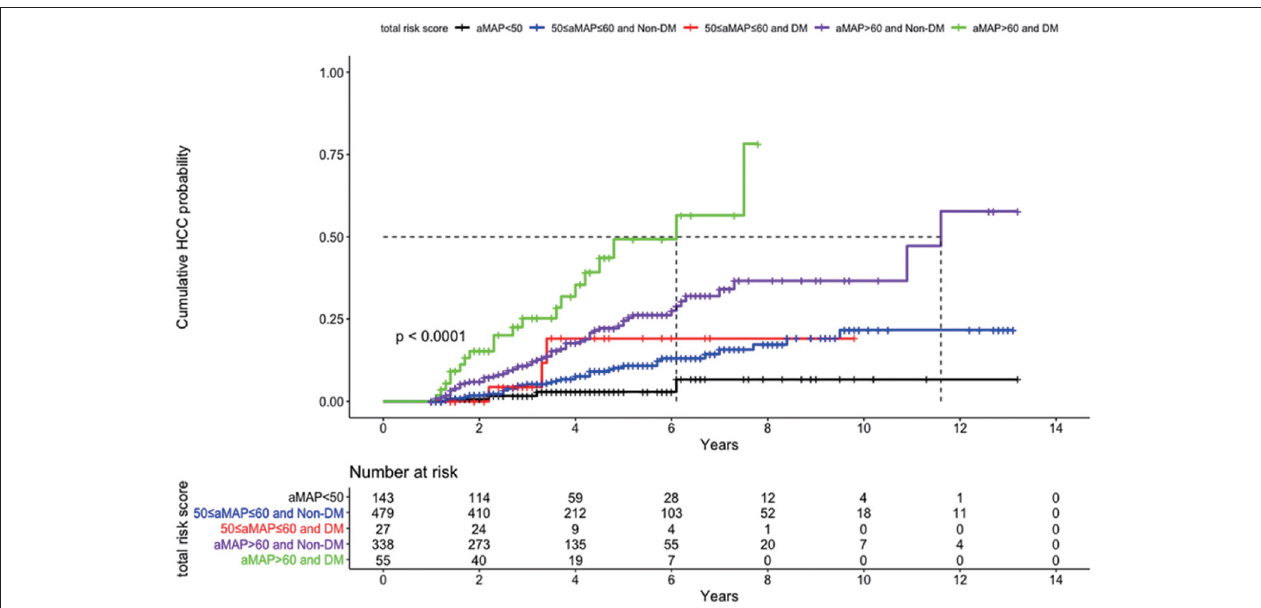
FIGURE 3 | Cumulative probability of development of HCC according to risk stratification by combination of aMAP and DM.